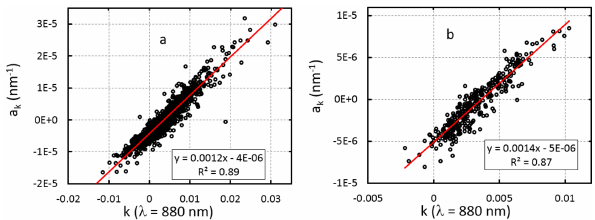
Figure 4. The slope of the wavelength dependency of the compen- sation parameter ( a k ) as a function of the compensation parameter k at λ = 880nm in (a) each filter spot change, (b) 24h averages.